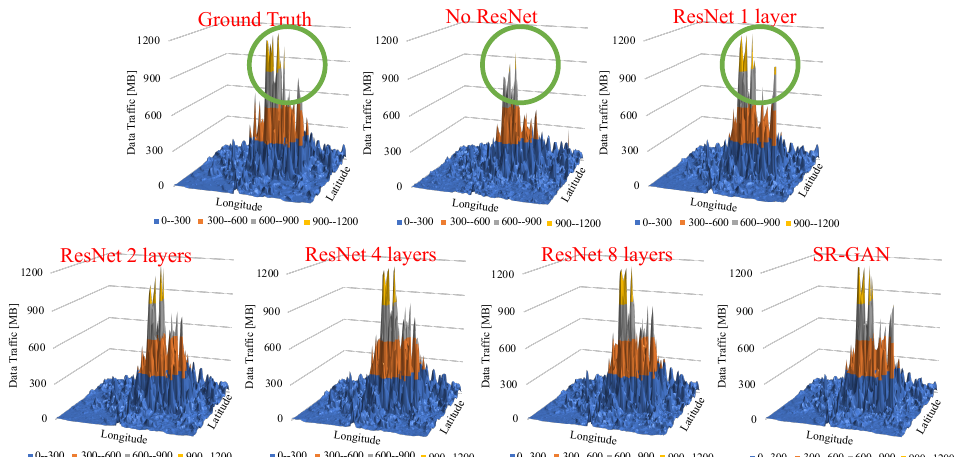
Figure 6. The snapshots of the output data of our proposed scheme with changes in ResNet size and SR-GAN (coarse-grained data as input), using data collected in Milan on 1 November 2013.